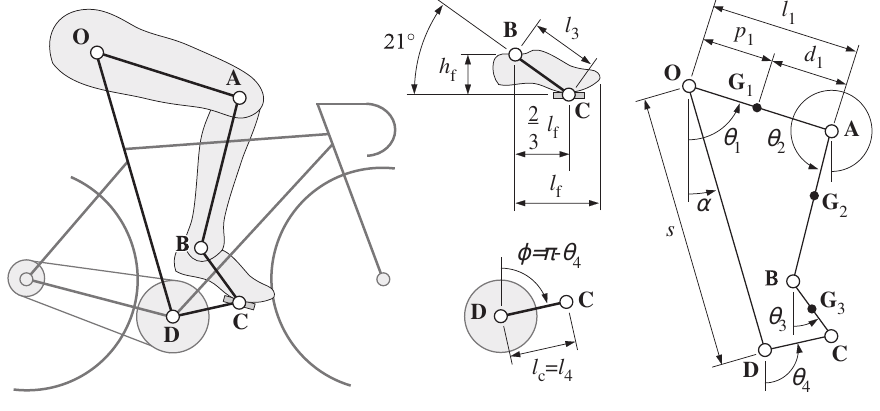
Figure 1. Planar kinematic